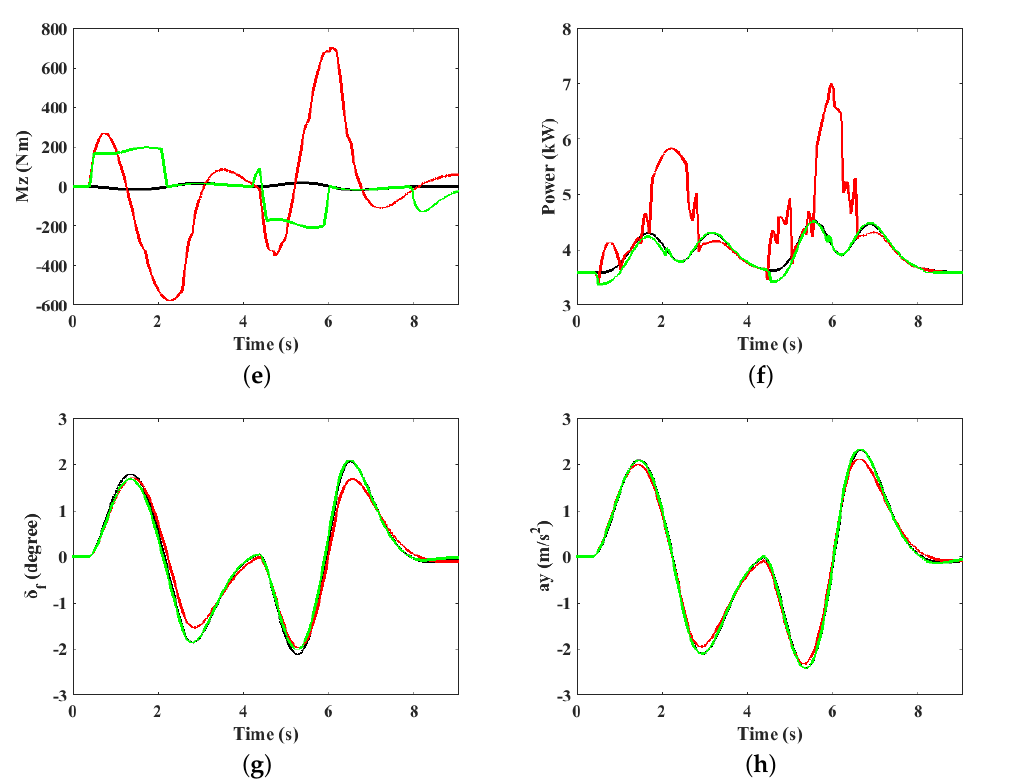
Figure 13. ISO 3888-1 double lane change with Motor I and v x = 50km/h: ( a ) Path; ( b ) Longitudinal velocity; ( c ) Working area; ( d ) Wheel torques; ( e ) Yaw moment; ( f ) Power; ( g ) Front steering angle; ( h ) Lateral acceleration.